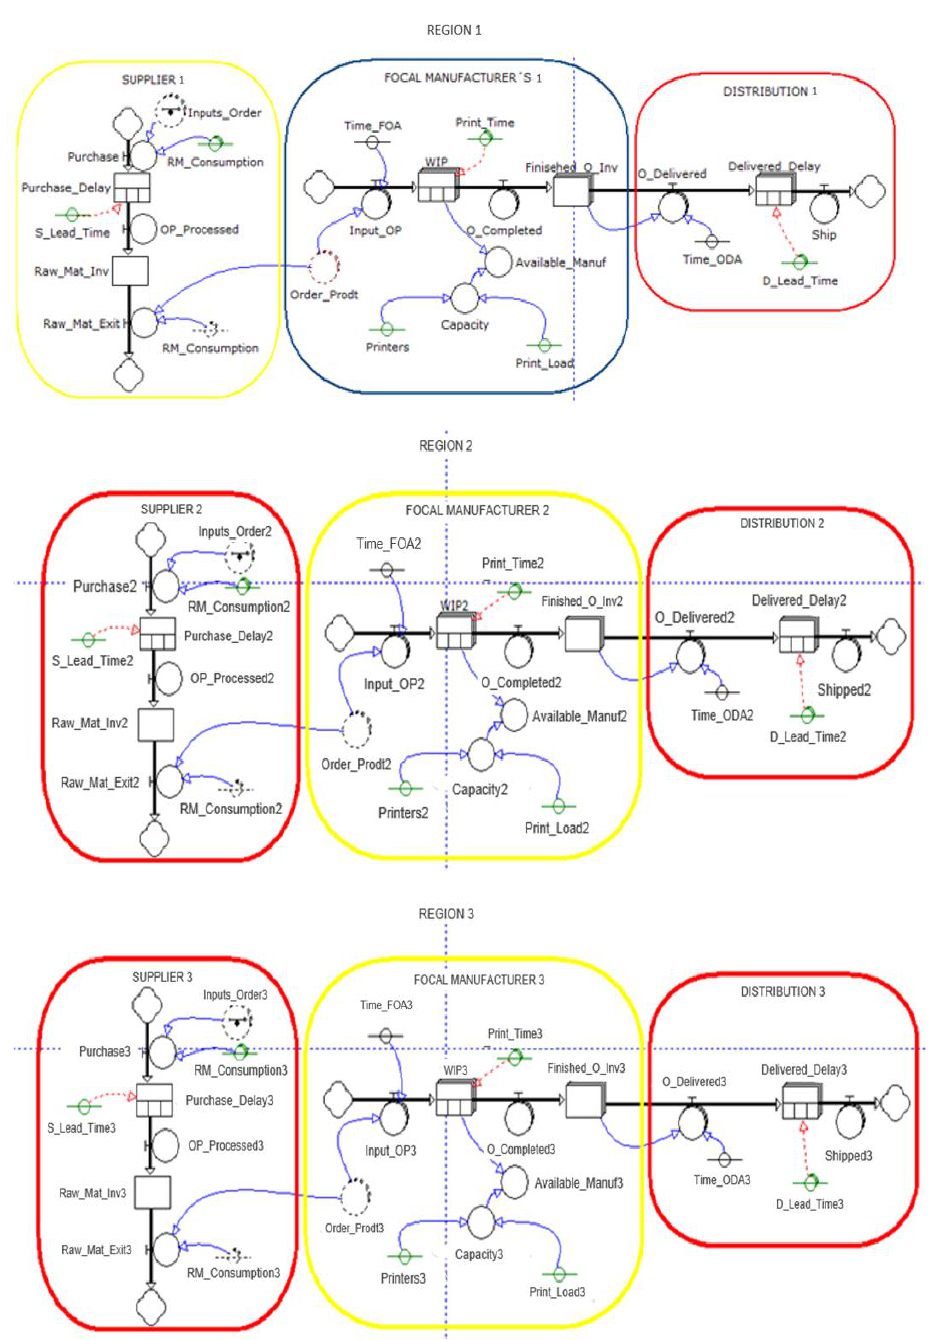
Figure 17. Structure of scenario 3 by region. Source: own elaboration. Evolution software. Figure 14. Structure of scenario 3 by region. Source: own elaboration. Evolution